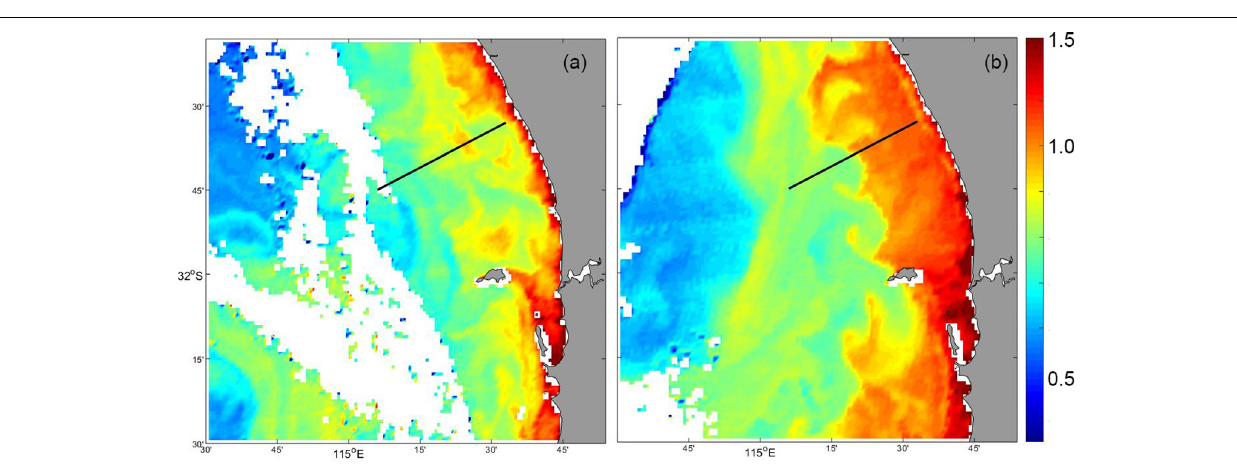
May 2016: Figure 12a ) and after (30 May 2016: Figure 12b